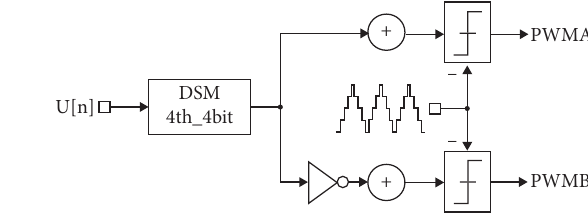
Figure 7: Block diagram of the